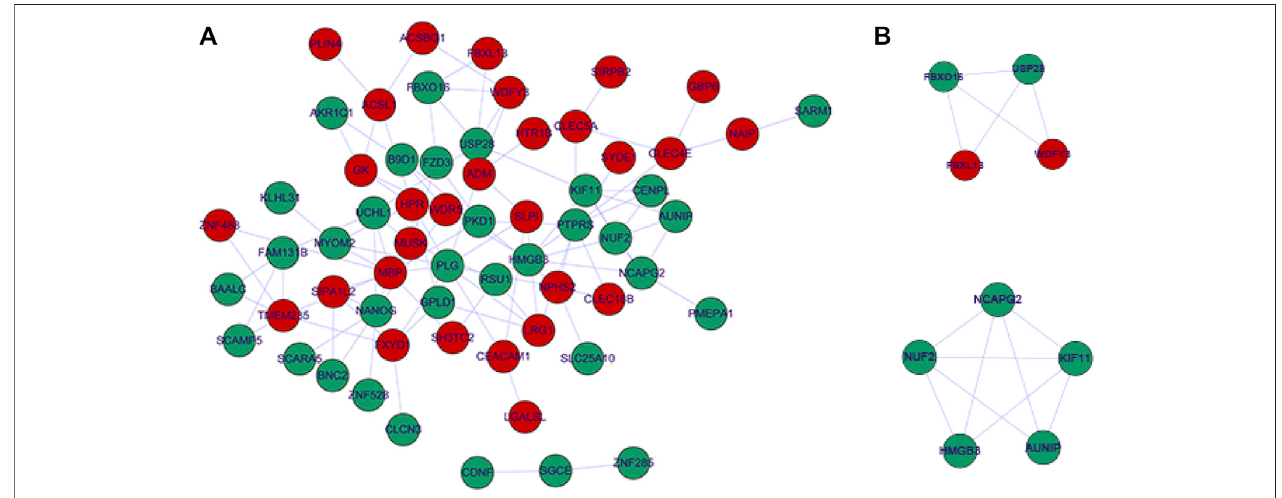
FIGURE 5 | Protein-protein interaction network complex. (A) The protein-protein interaction network visualized by Cytoscape. Red nodes represent up-regulated expression, Green nodes represent up-regulated expression. (B) Top two PPI networks in MCODE analysis.